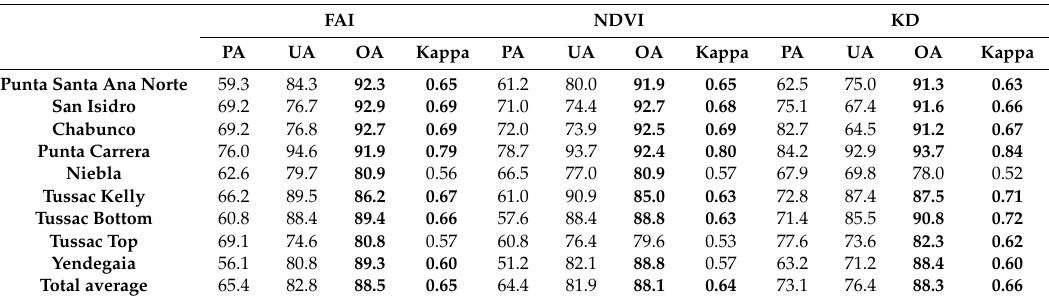
Table 5. Confusion matrix results for maps obtained using the kelp filter algorithm employing the FAI, NDVI, and the KD in forests larger than 1 hectare. PA = Producer’s Accuracy (%). UA = User’s Accuracy (%). OA = Overall Accuracy (%). Overall Accuracies > 80 and Kappa coe ffi cients > 0.6 are highlighted in bold.